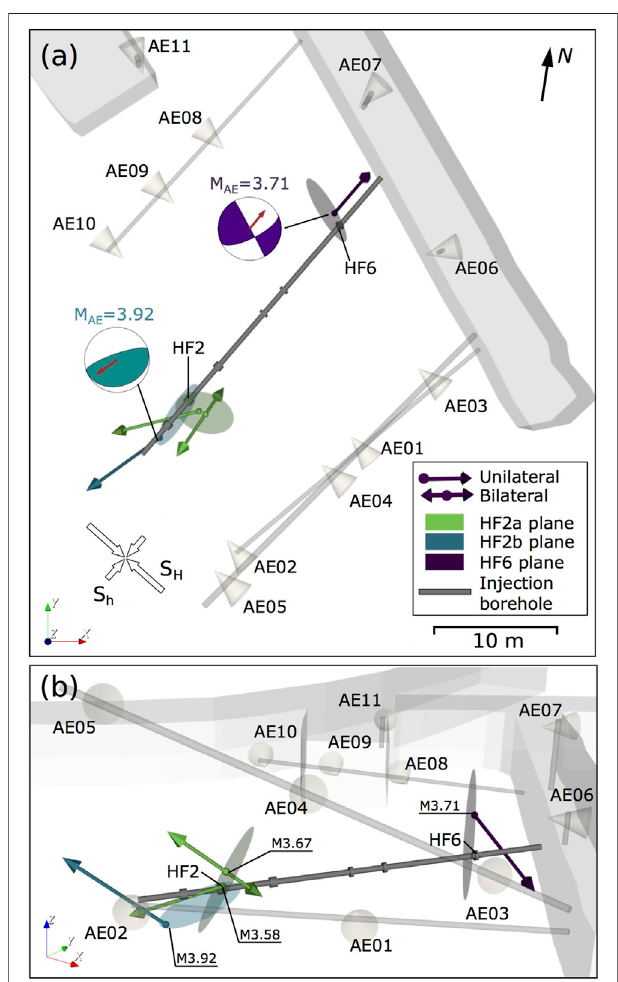
FIGURE 4 | 3D views of the resulting rupture directivity vectors for the fourlargesttargetAEeventsintheÄspöHRL: (A) topviewand (B) perspective view. Planar seismogenic regions identi fi ed by the AE activity (Niemz et al., 2020) are shown considering the hypocentral locations of our target events. The AE sensors are located in nearby boreholes and tunnel; they are oriented toward the stimulated volume along the 28-m-long injection borehole. Focal mechanisms obtained by Kwiatek et al. (2018) for the largest AE event in HF2 and HF6 are shown with their rupture directivity vectors (brown arrows) in (A) . M AE is indicated for the target events in (B)